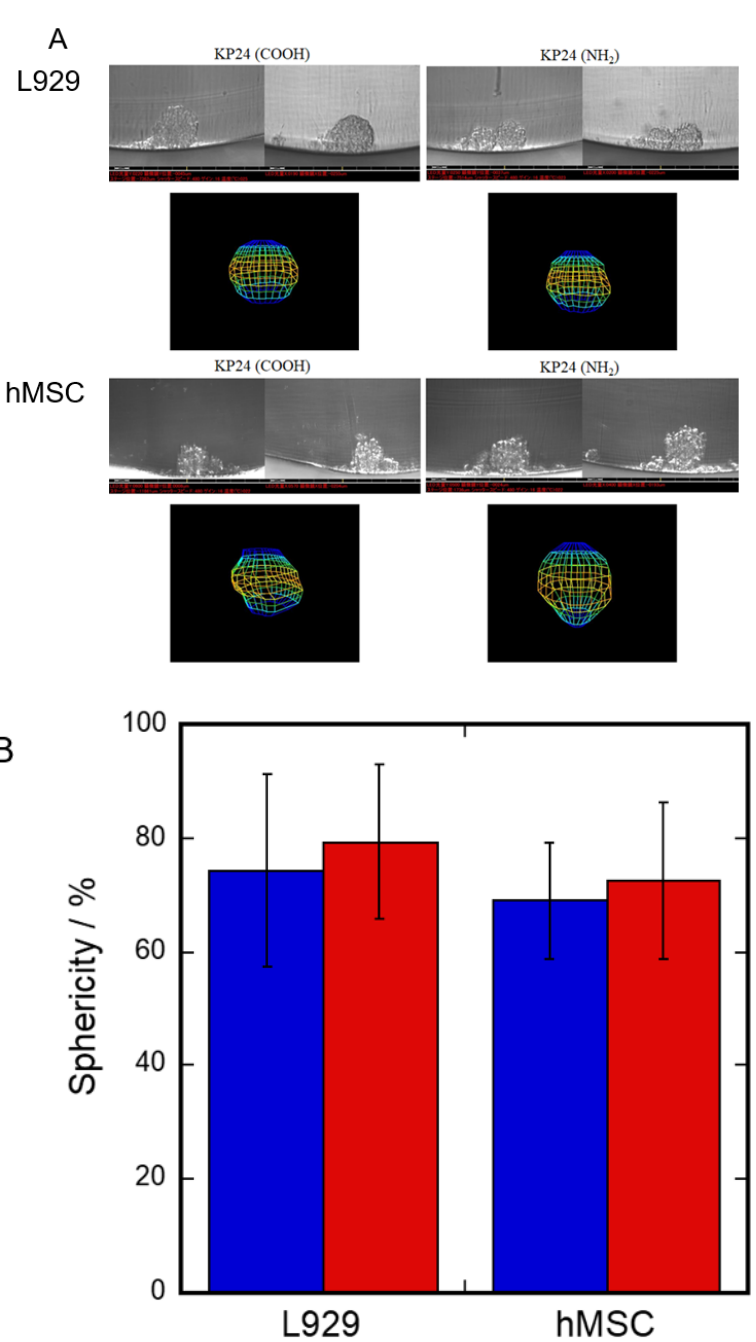
Figure 6. ( A ) Microphotograph of Mil-Cell analysis and 3D analysis (bottom view; side view, 3D image). ( B ) Sphericity of cell aggregate. Red, KP24 (NH 2 ) substrate; blue, KP24 (COOH) substrate.